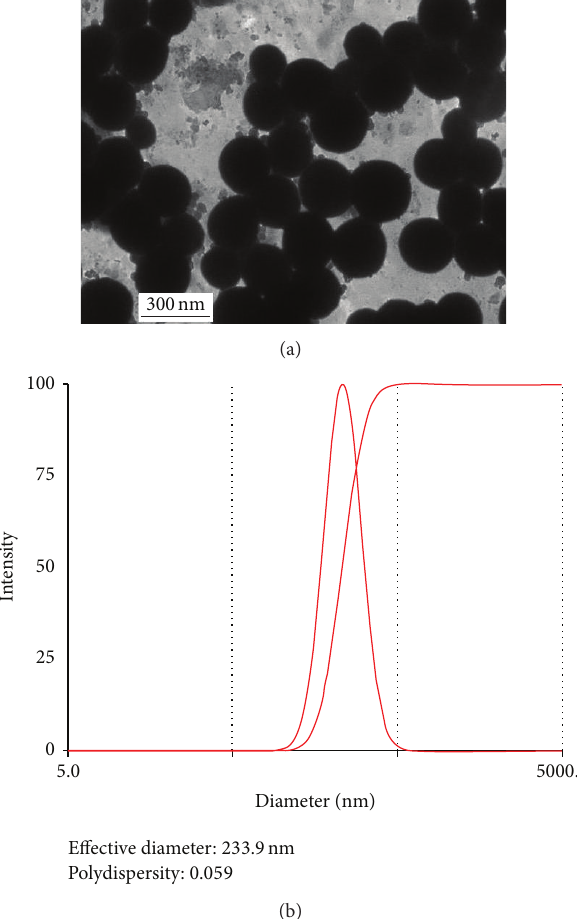
Figure 2: Size and distribution of 131 I-antiAFPMcAb-GCV-BSA- NPs. (a) TEM image of 131 I-antiAFPMcAb-GCV-BSA-NPs. The particles were approximately spherical and their diameters were about 220–280 nm. (b) Diameter and particle distribution of 131 I- antiAFPMcAb-GCV-BSA-NPs examined by laser particle size ana- lyzer. The average diameter was 233.9 nm. The polydispersity index (PDI) of the particles was